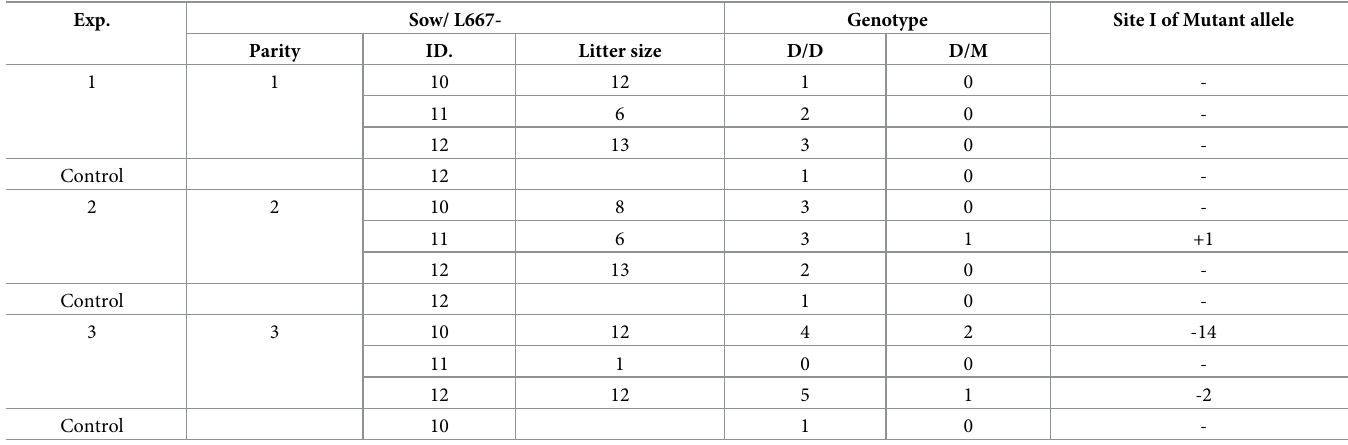
offspring (S5 Fig) lacked NGNA expression. These results show that all founders and their off- spring are biallelic mutants that fail to express CMAH and produce no NGNA in their tissues. Clinical observation of neonatal piglets challenged with nv-PEDV Exp. I : When neonatal 2-day-old piglets were challenged with nv-PEDV, both the CMAH mutant (Knockout, KO) and wild-type (WT) animals initially displayed clinical signs of Table 4. Genotypes of the F1 CMAH KO piglets used for PEDV challenge.